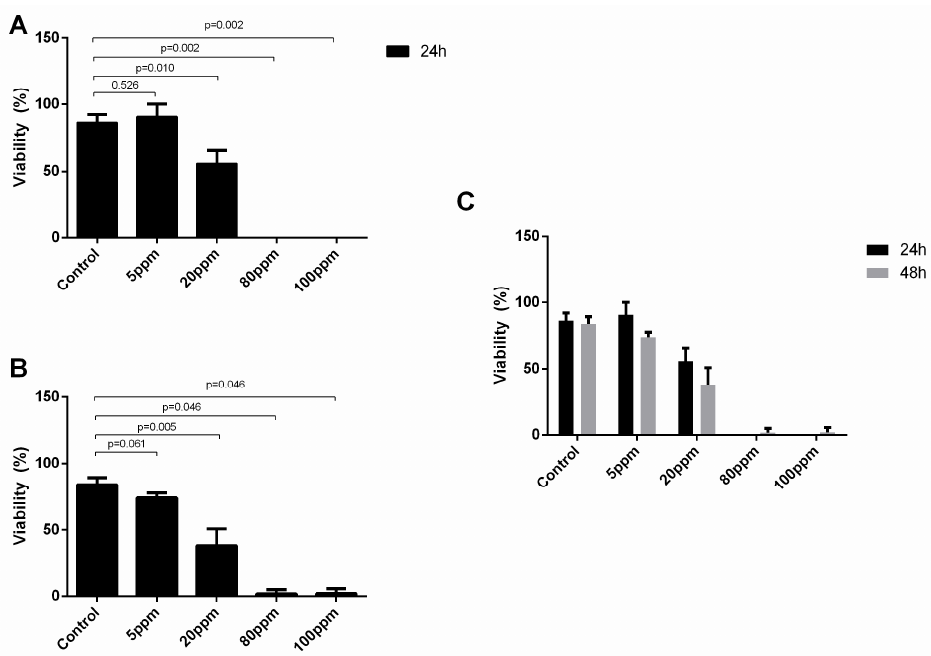
Figure 4. LNCaP cells viability assessed by trypan blue exclusion method upon treatment with AgNPs for 24 h ( A ) and 48 h ( B ) and the comparison between their effect at the two time points ( C ). Results are expressed as percentage of control (untreated cells), as mean ± SEM.